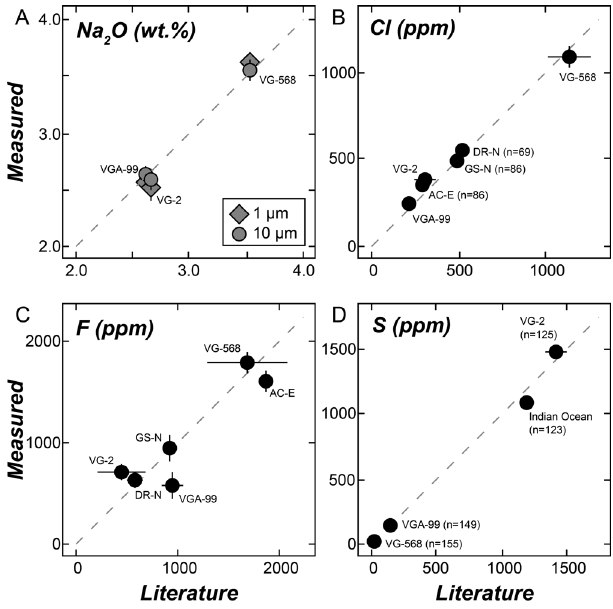
Figure 3: EPMA analysis of reference glasses. [A] Na measured using 1 and 10 µm diameter electron